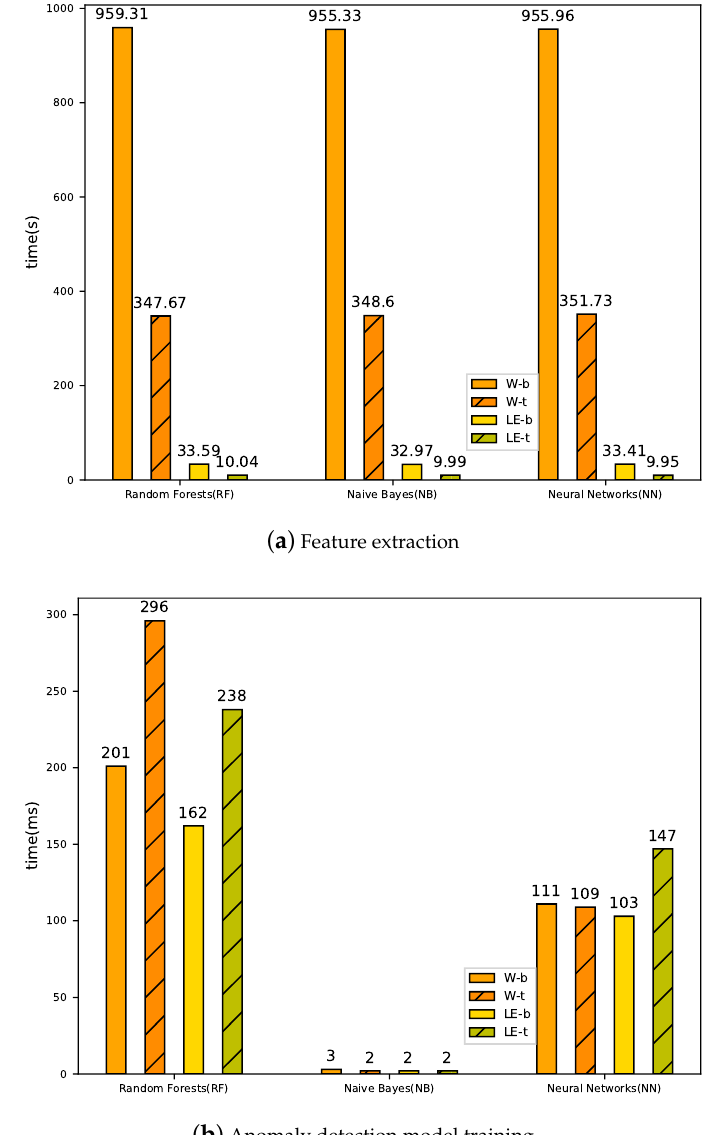
Figure 5. Computational time of the feature extraction and anomaly detection with bary and tf-idf coordinate transformations. ( a ) computational time of feature extraction; ( b ) computational time of anomaly detection model